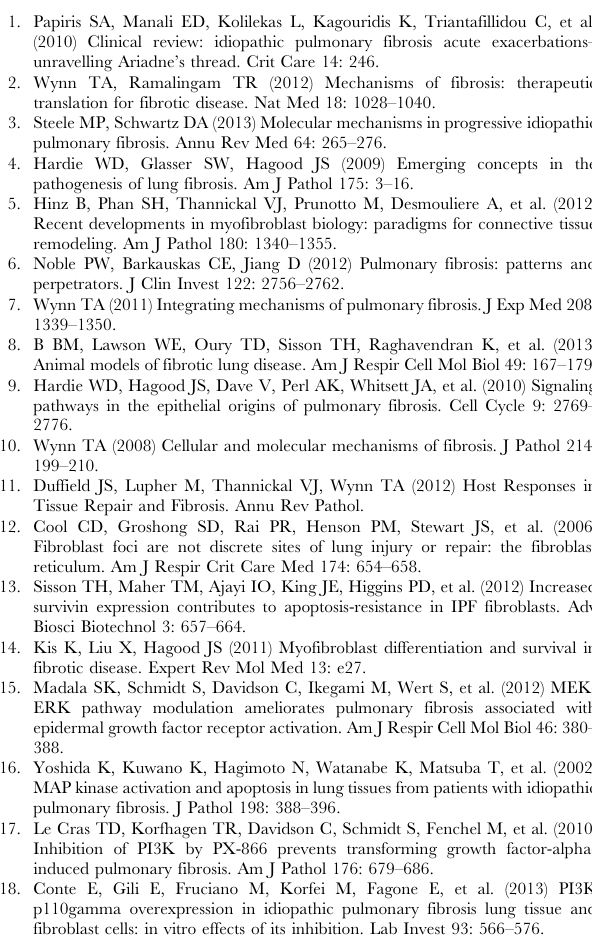
Figure S2 Representative photomicrograph of lung tissue sections immunostained for Ki67 for each treat- ment group. Scale bar, 100 m m. Figure S3 Expression of MYCN in the lungs of individ- uals with interstitial lung disease. Average Mycn mRNA levels are elevated in individuals with interstitial lung disease compared to controls and COPD. Mycn expression data was extracted from mRNA expression catalogue available in the database of Lung Genomic Research Consortium (LGRC)